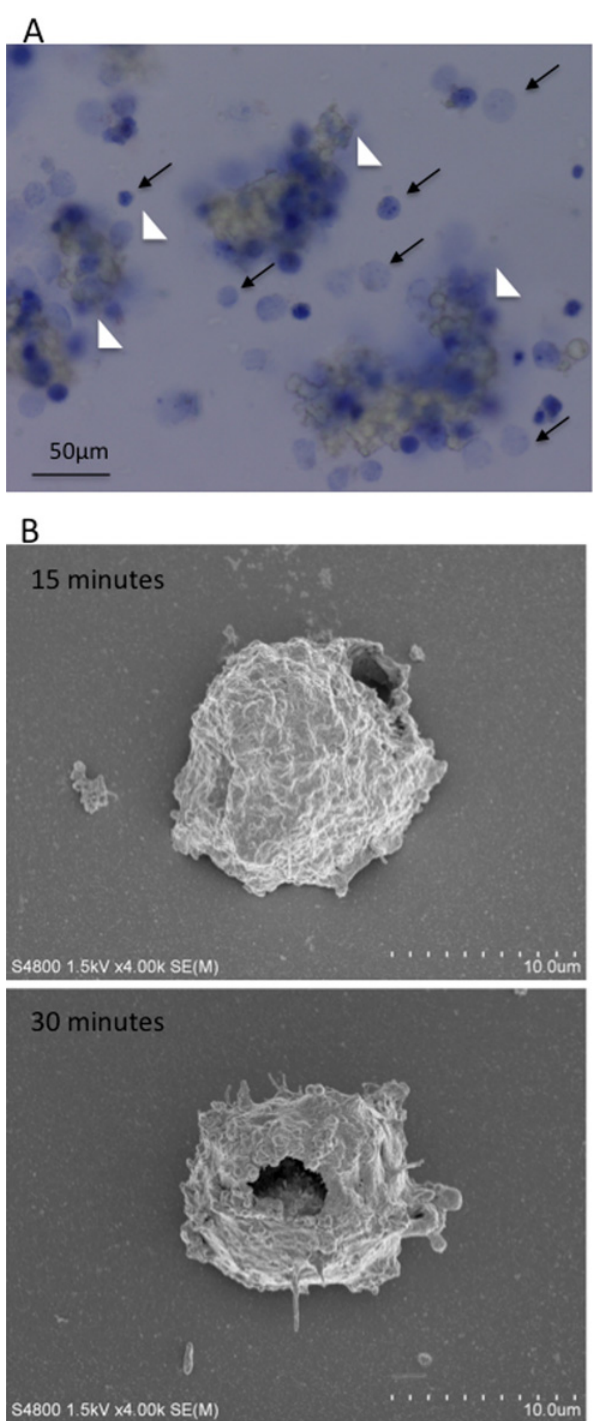
Fig 5. Microscopy analysis of mAb 4713-induced single cell death shows giant pores. (A) Light microscopy image showing that the incubation of L428 cells with mAb 4713 caused rapid aggregation and death of single cells after 30 min, as shown by trypan blue exclusion staining. , single cell death; Δ , aggregation of cells. Bar: 50 μ m (B) Scanning electron microscopy image showing the formation of giant pores on L428 Hodgkin lymphoma cells after a 15 or 30 min incubation with mAb